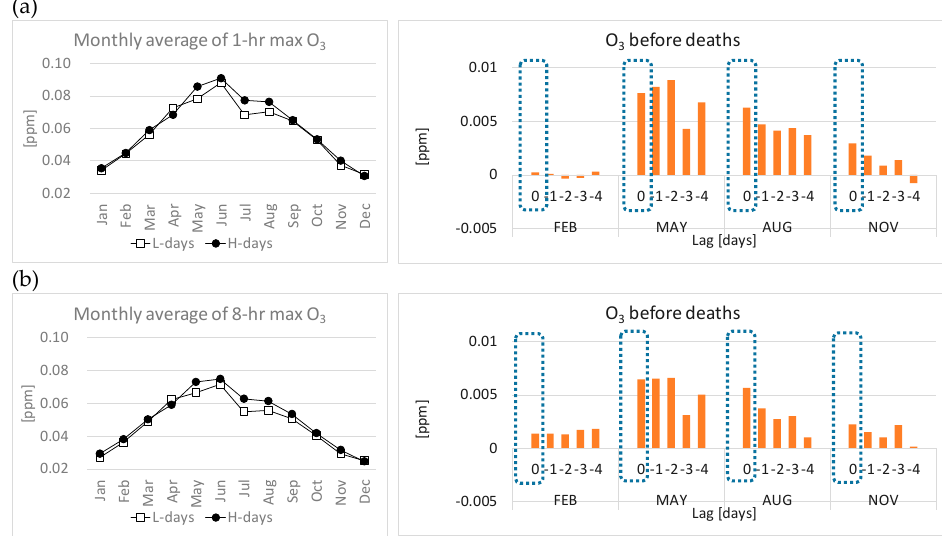
Figure 3. Ozone (O 3 ) concentrations on days with a higher or lower probability of deaths from respiratory disease, and those from zero to 5 days before death in February, May, August, and November between 2008 and 2017: ( a ) 1-hour and ( b ) 8-hour maximum O 3 concentrations. PM 2.5 concentrations did not show clear differences between the days with high and low numbers of deaths (Figure 4). Differences in PM 2.5 concentrations in August did not consistently increase or decrease on days before death. However, differences 1 day and 2 days before death increased in February, May, and November, while differences decreased 3, 4, and 5 days before death. These results imply that high PM 2.5 1 day or 2 days before death is associated with deaths from